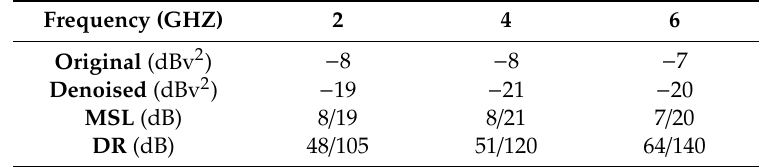
Table 1. Maximum Sidelobe Level (MSL) and dynamic range (DR) results for electromagnetic interference sources (EMIS) at 2 GHz, 4 GHz, and 6 GHz before and after